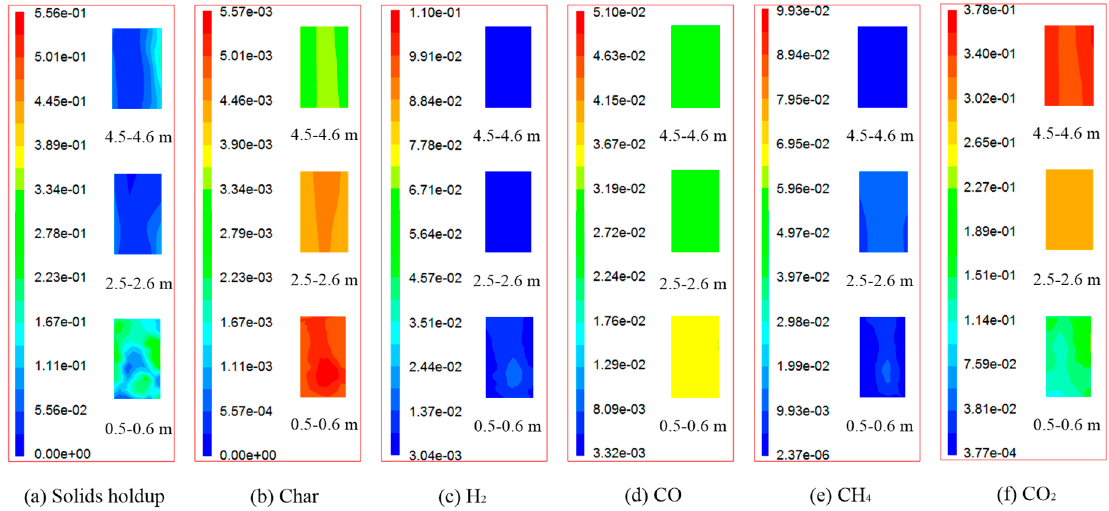
Figure 4. Axial (x = 0) distributions of solids holdup and gas–solid components along the bed height at 70 s with the reference condition: G p = 100 kg/m 2 · s, Q h = 7.5 m 3 /h, P 0 = 0.55 MPa. ( a ) solids holdup; ( b ) mass fraction of char in solid phase; ( c – f ) molar fractions of gas species in gas phase.